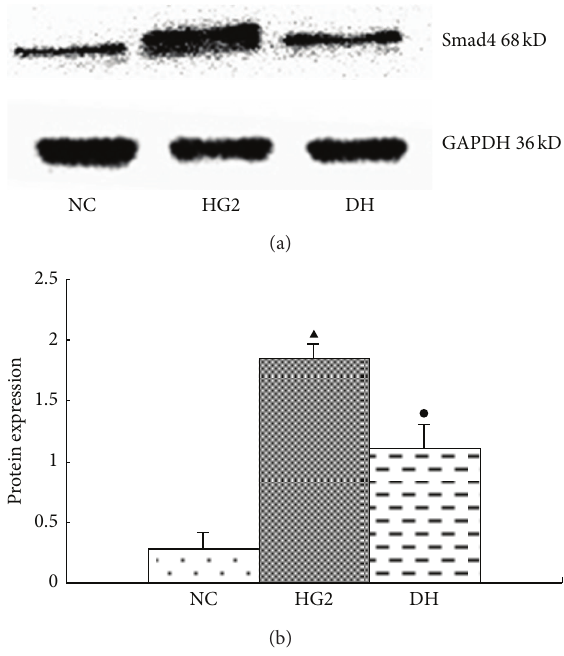
Figure 9: The expression of Smad4 after intervention with DAPT determined using western blot for 24 hr. (a) Western blot strip chart. (b) The gray graph shows the relative statistical values for Smad4 in each group. Compared with the NC group, the expression of the Smad4 protein was significantly increased in the HG2 group. After DAPT intervention, the protein expression of Smad4 decreased. 󳵳 𝑃 < 0.05 versus NC group; ∙ 𝑃 < 0.05 versus HG2 group.